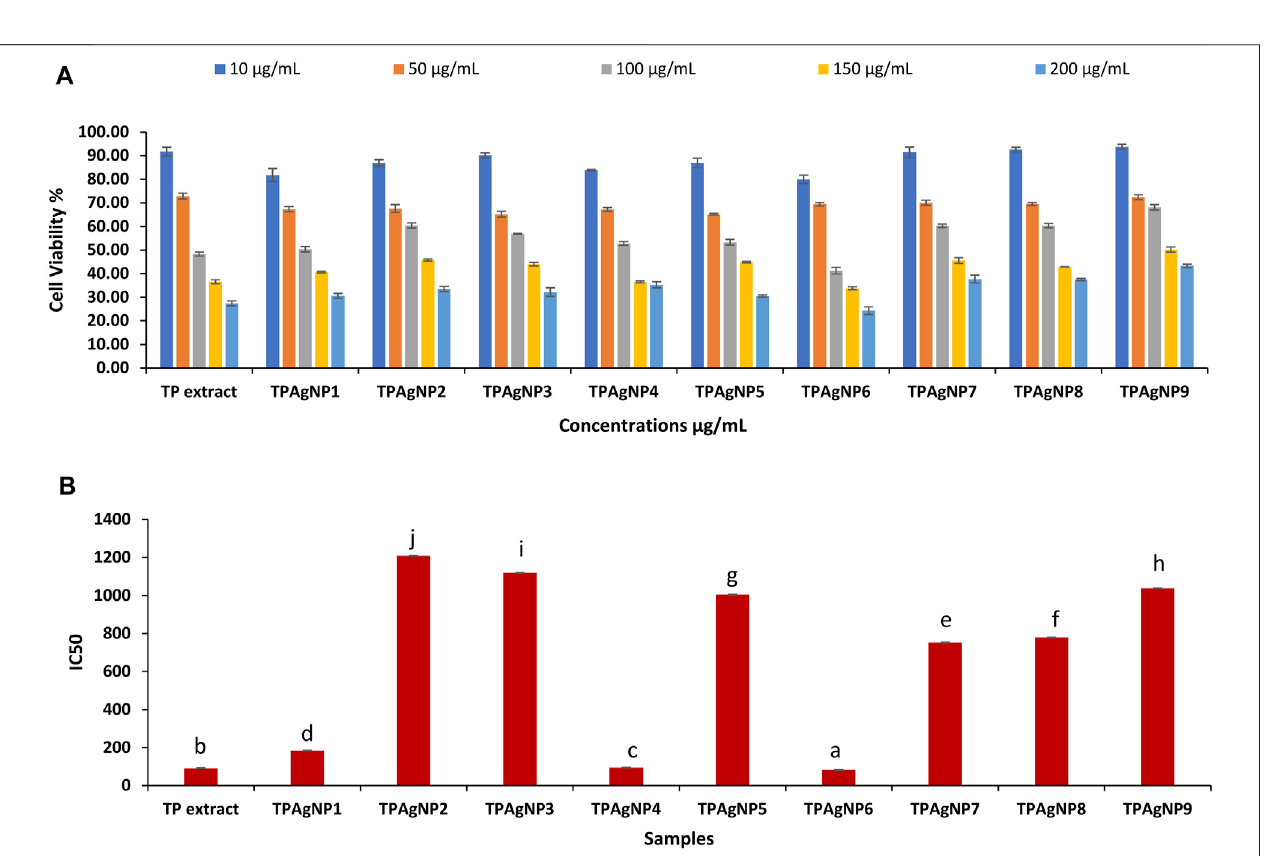
FIGURE 1 | Result of cytotoxicity assay of plant extract and TpAgNPs of T. pallida (A) and IC 50 values of extract and nanoparticles (B) .